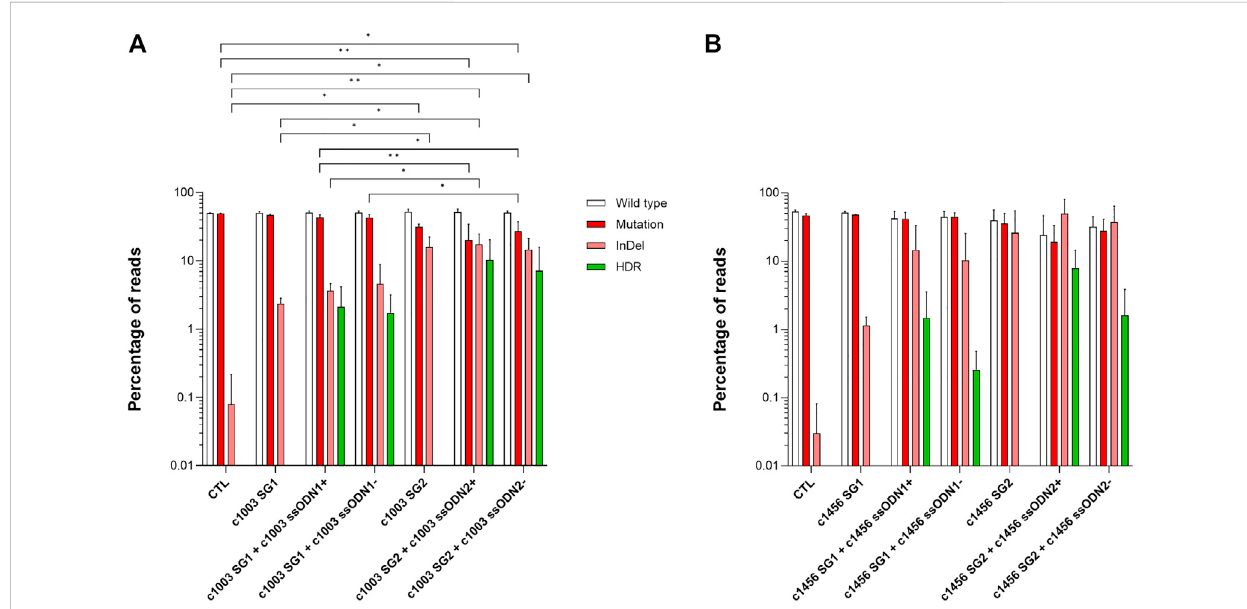
FIGURE 2 Correction of different point mutations present in a second PKD patient (A) Frequency of the different reads identi fi ed by Next-Generation Sequencing in PKD-LCLs gene-edited with the speci fi c gene editing tools for c.1003 G > A mutation (B) Frequency of the different reads identi fi ed